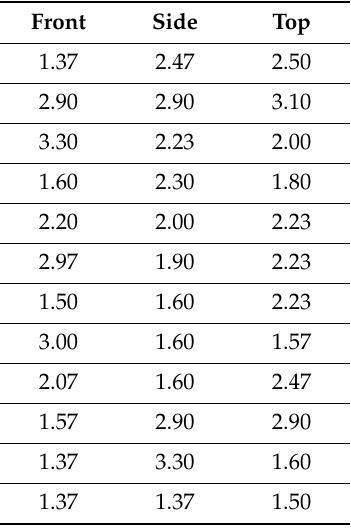
Table 26. DOE setup for Ra as a function of build orientations.